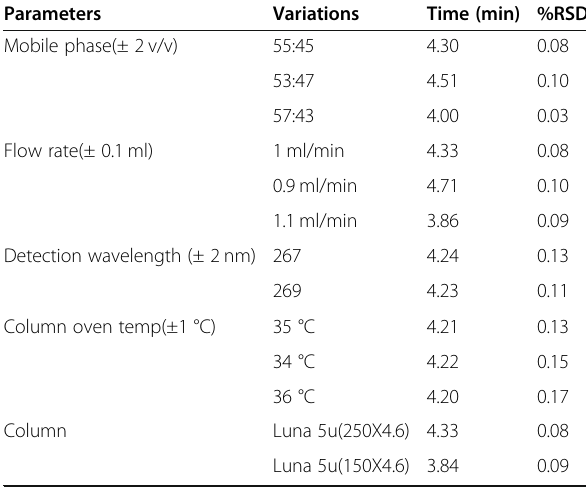
Table 4 Results of intra-day precision of apigenin solution Experiment time for day